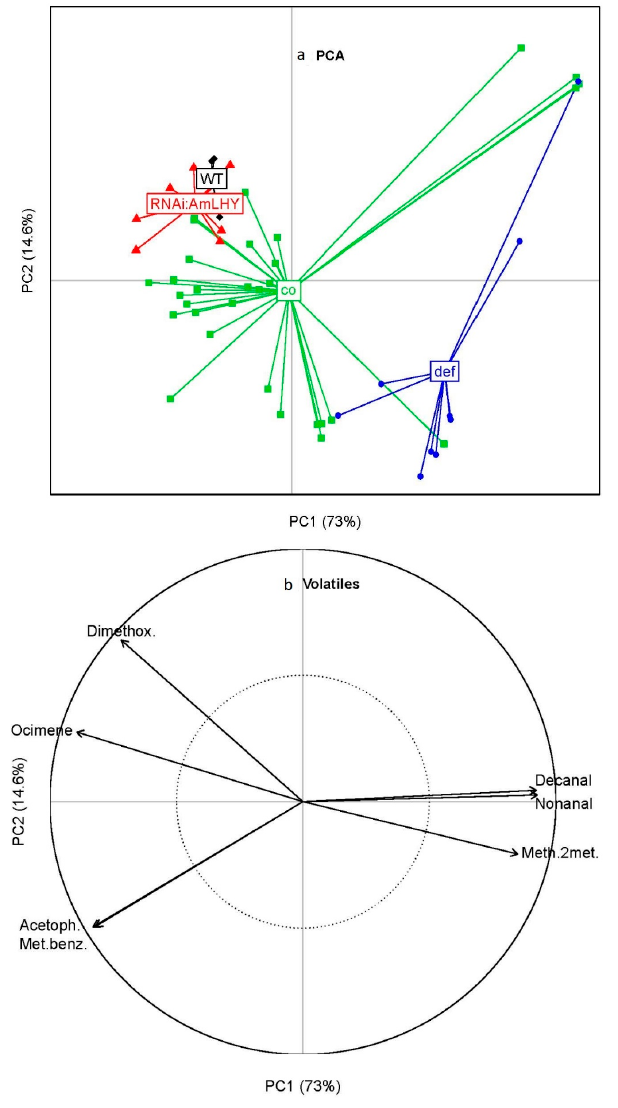
Figure 9. Principal component analysis of snapdragon groups based on their emitted compounds. The axis PC1 and PC2 explains the 73% and 14.6% of the total variance respectively ( a ). Correlation circle plot that represents the contribution of volatiles ( b ). PC. Principal Component, co: compacta , def: deficiens , WT: wild-type, Dimethox.: 3,5-dimethoxytoluene, Acetoph.: acetophenone, Met.Benz.: methyl benzoate, Meth.2met.: methyl 2-methylbutyrate.